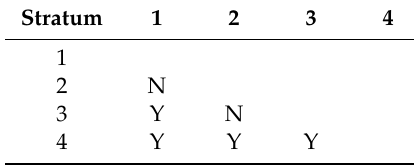
Figure 4. The subregions of the GPC and their LE. Table 5. Significance of average LE difference between different layers of GPC (GDP per capita).